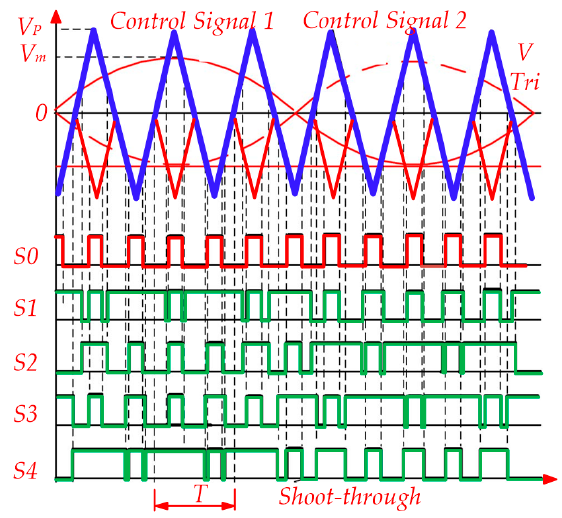
Figure 4. PWM simple boost control strategy for the qSBI topology.